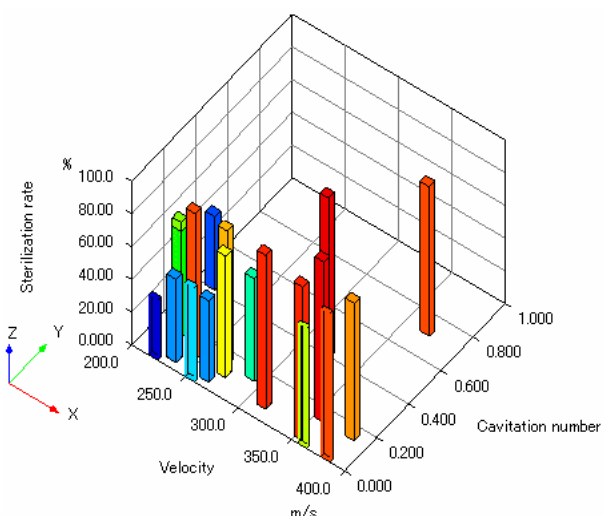
Fig. 10 Sterilization rate against velocity and cavitation number for E